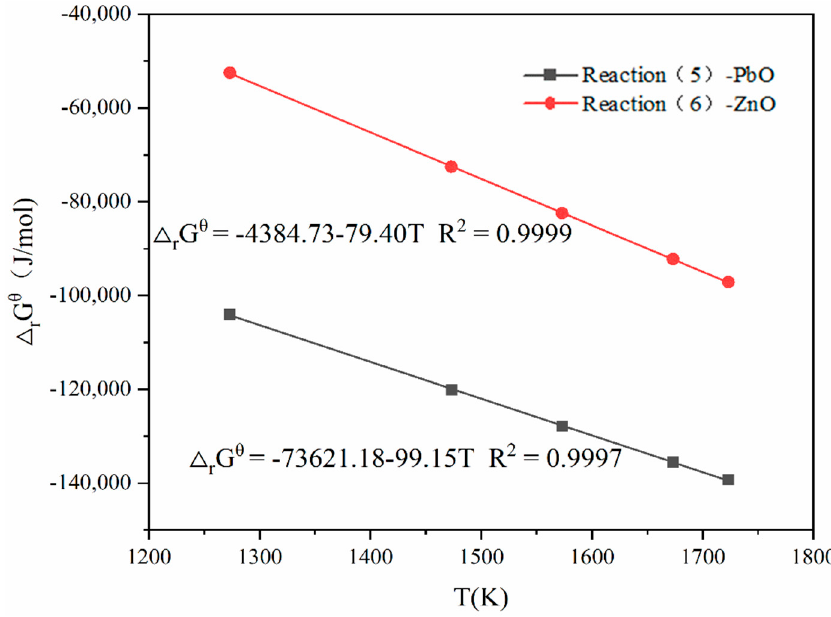
Figure 7. Standard Gibbs free energy of PbO/ZnO chlorination reaction at different temperatures and linear fitting results.